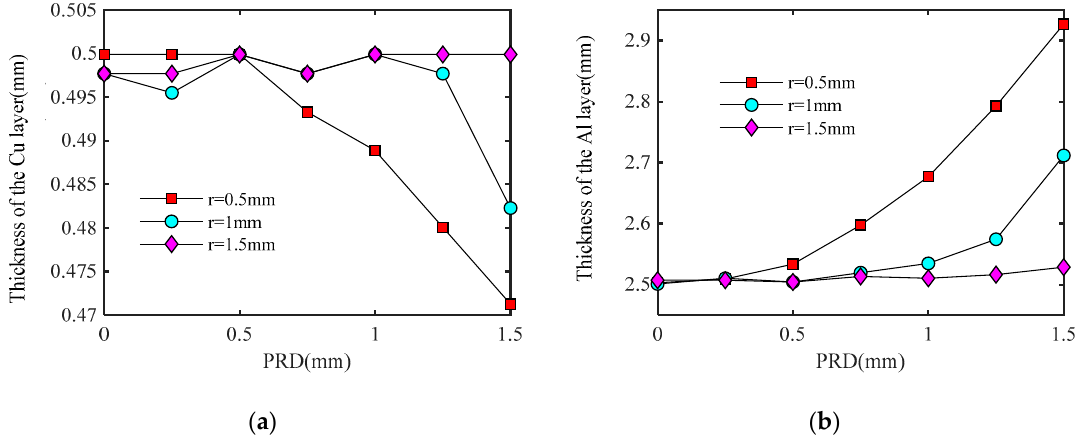
Figure 6. The in fl uence of PRD and radius of pulsed laser spot on calculated results: ( a ) Cu; ( b ) Al.